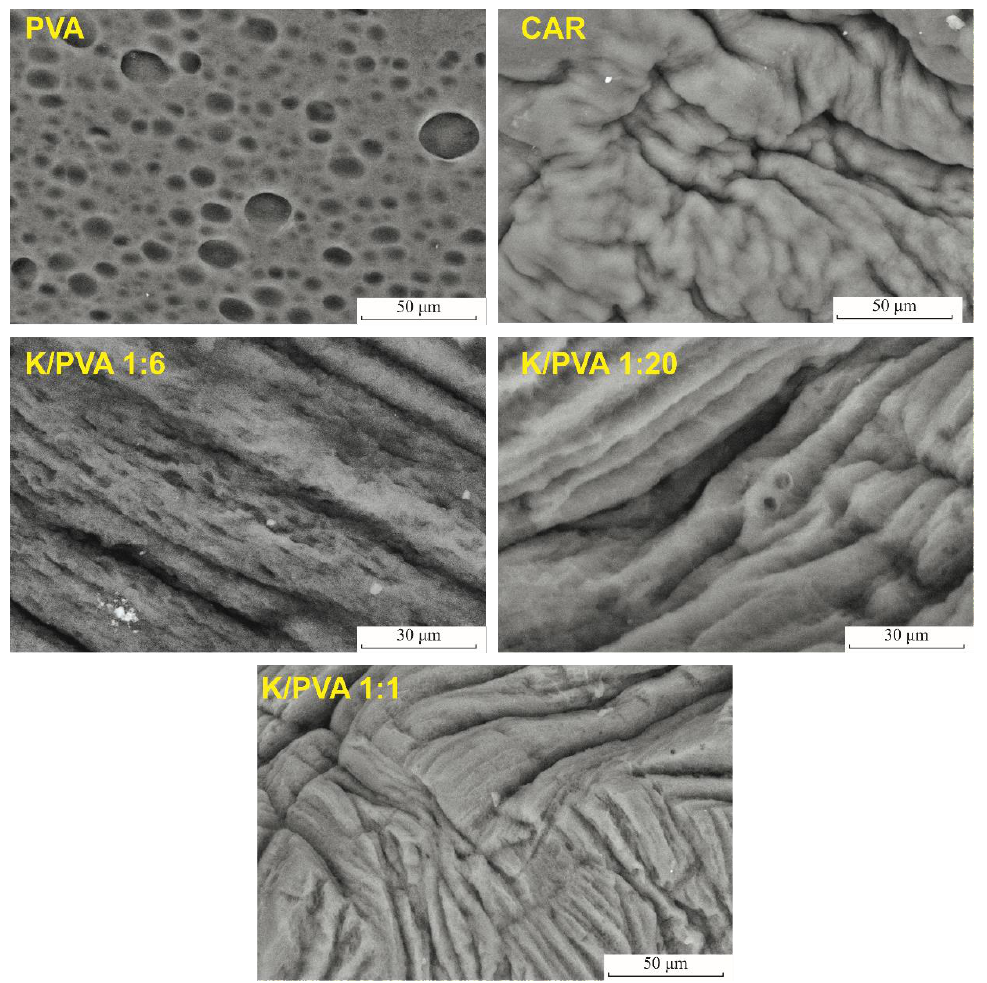
Figure 4. SEM micrographs of the obtained hydrogels.